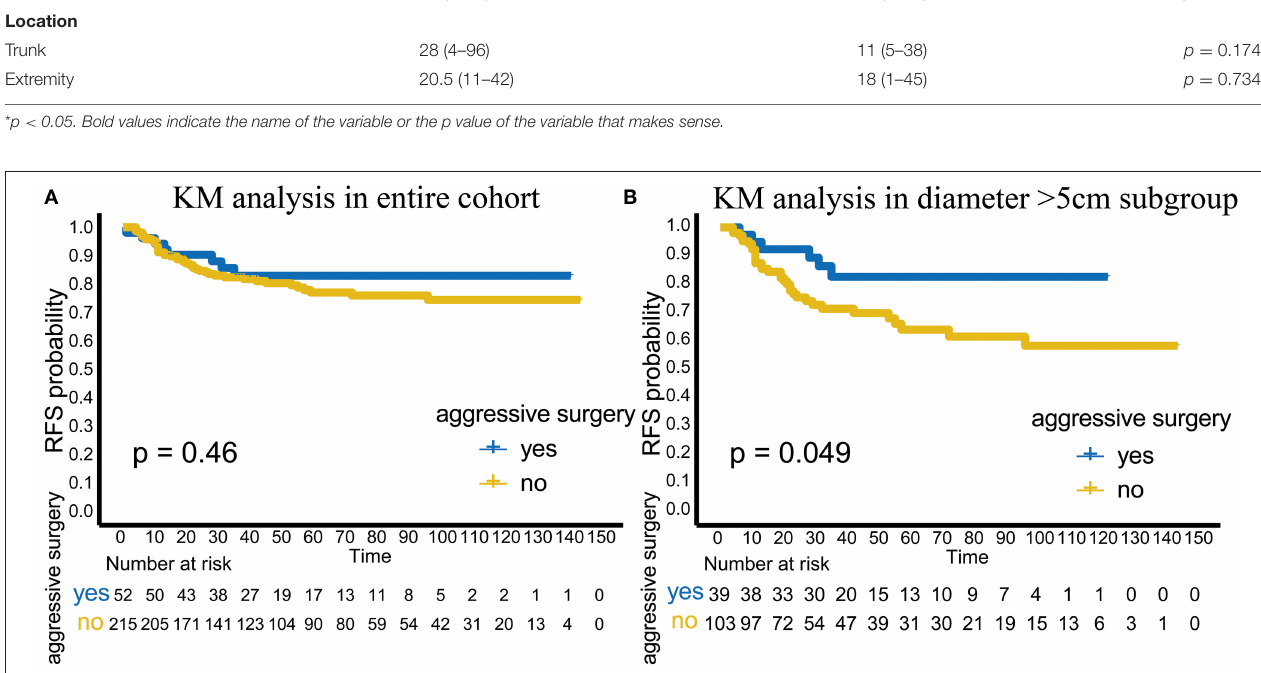
FIGURE 2 | Analysis of aggressive surgery in different groups. (A) The efficacy of aggressive surgery in the entire cohort. (B) The efficacy of aggressive surgery in the tumor diameter > 5cm